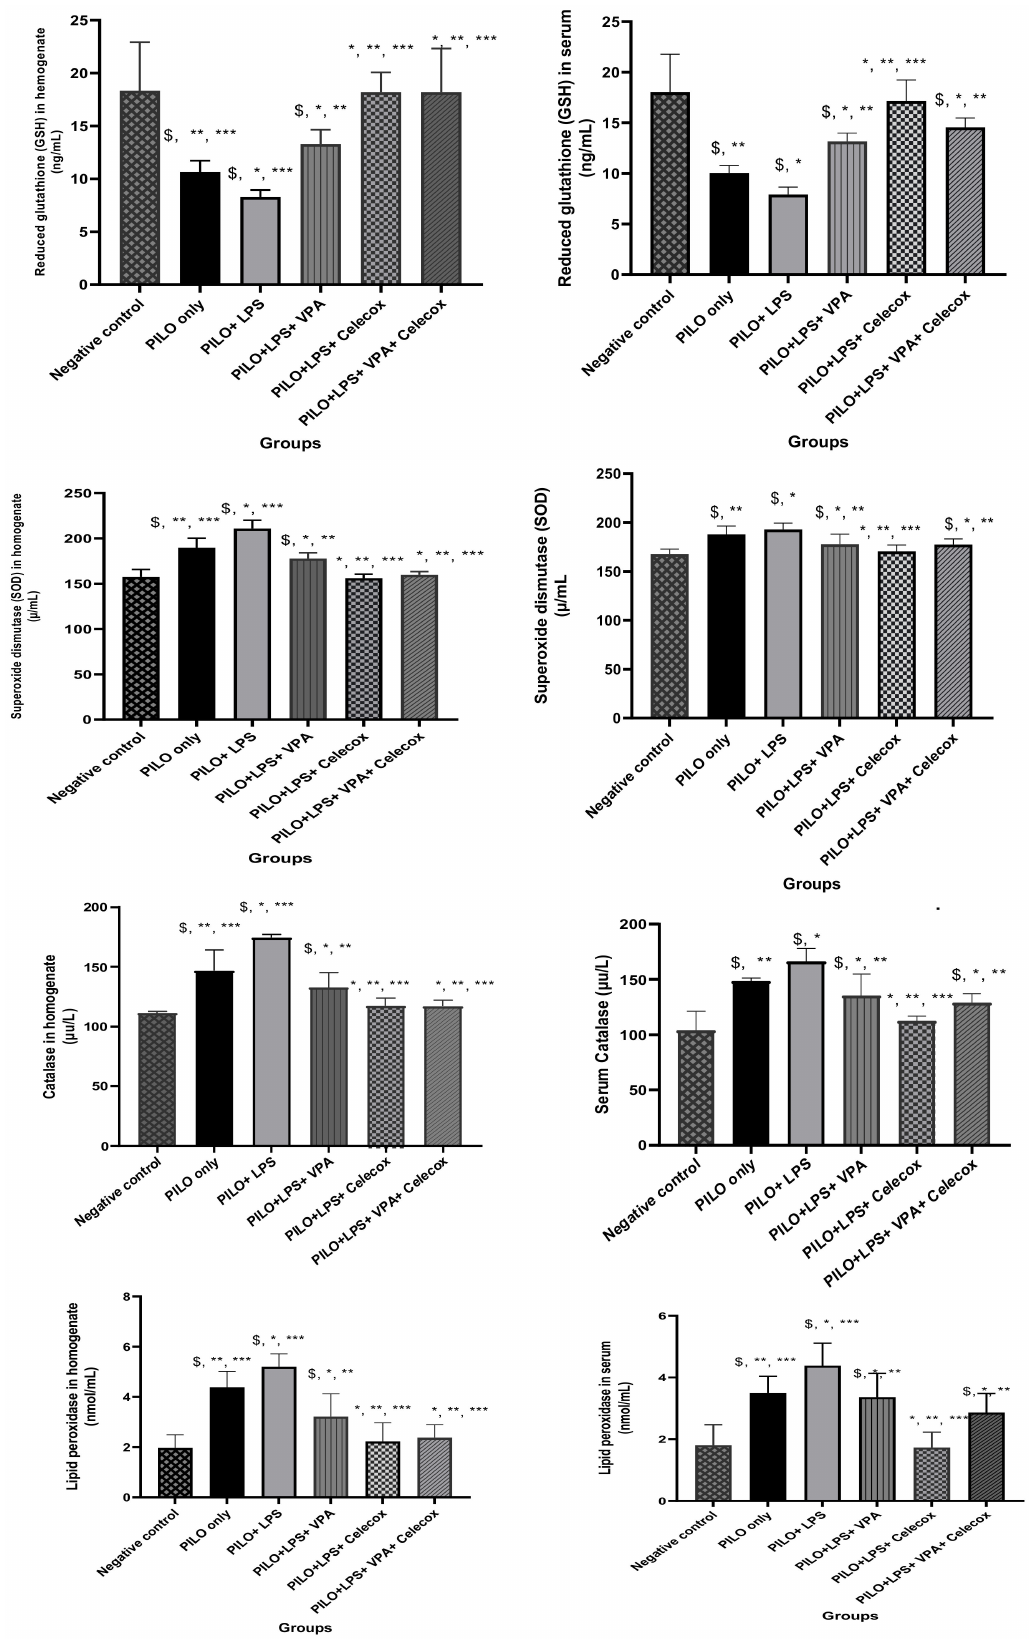
Figure 2. Effects of test drugs on oxidative stress markers in serum and hippocampus homogenate in rats of different groups. Data were expressed as mean +/ − standard deviation. PILO: pilocarpine, LPS: lipopolysaccharides; VPA: